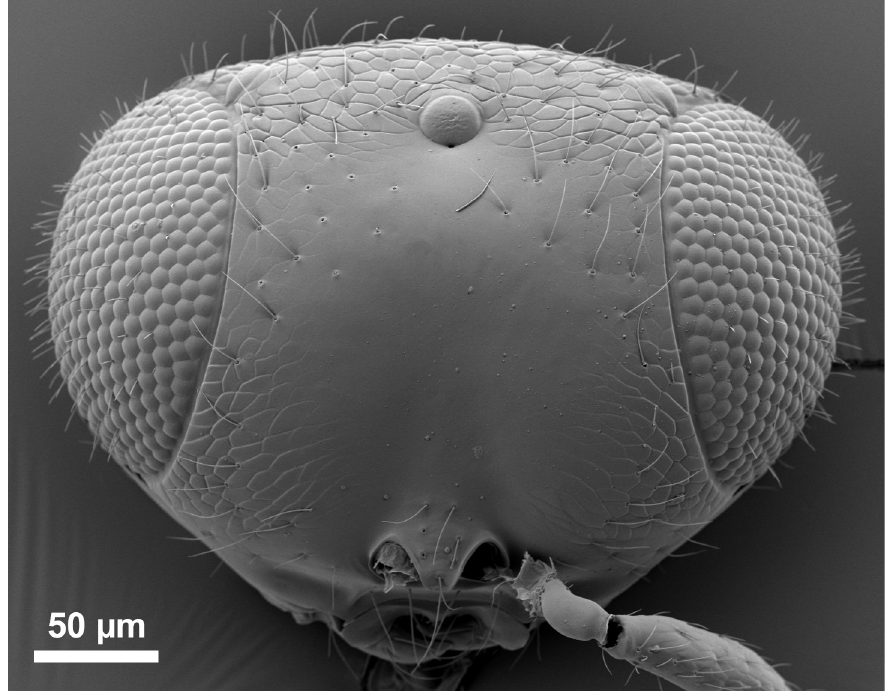
Fig 3. Telenomus nizwaensis Polaszek male paratype. Face.